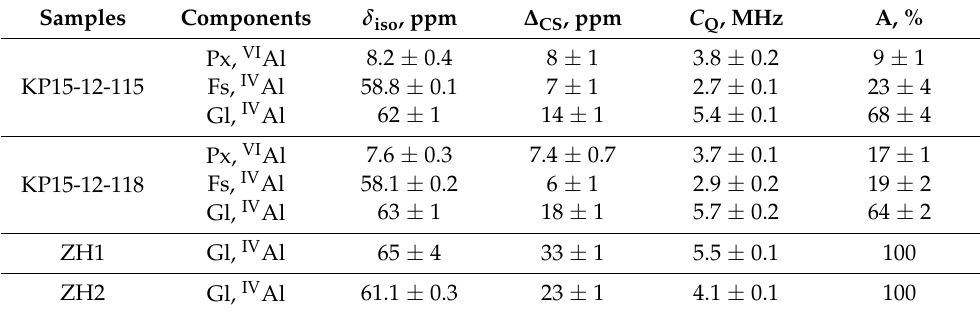
Table 2. The fitted Czjzek parameters of components of the 27 Al MAS NMR of the impact glasses. Samples Components δ iso , ppm ∆ CS ,